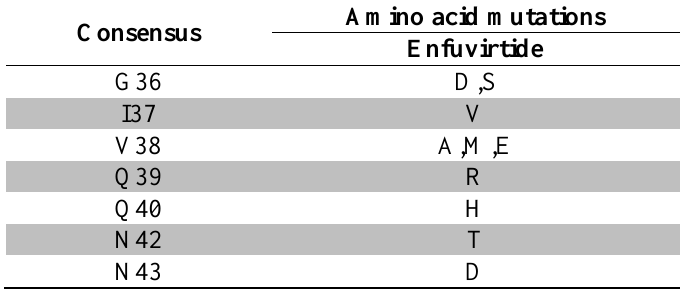
Table 6. Major Mutations in The Envelope Gene Associated with Resistance to